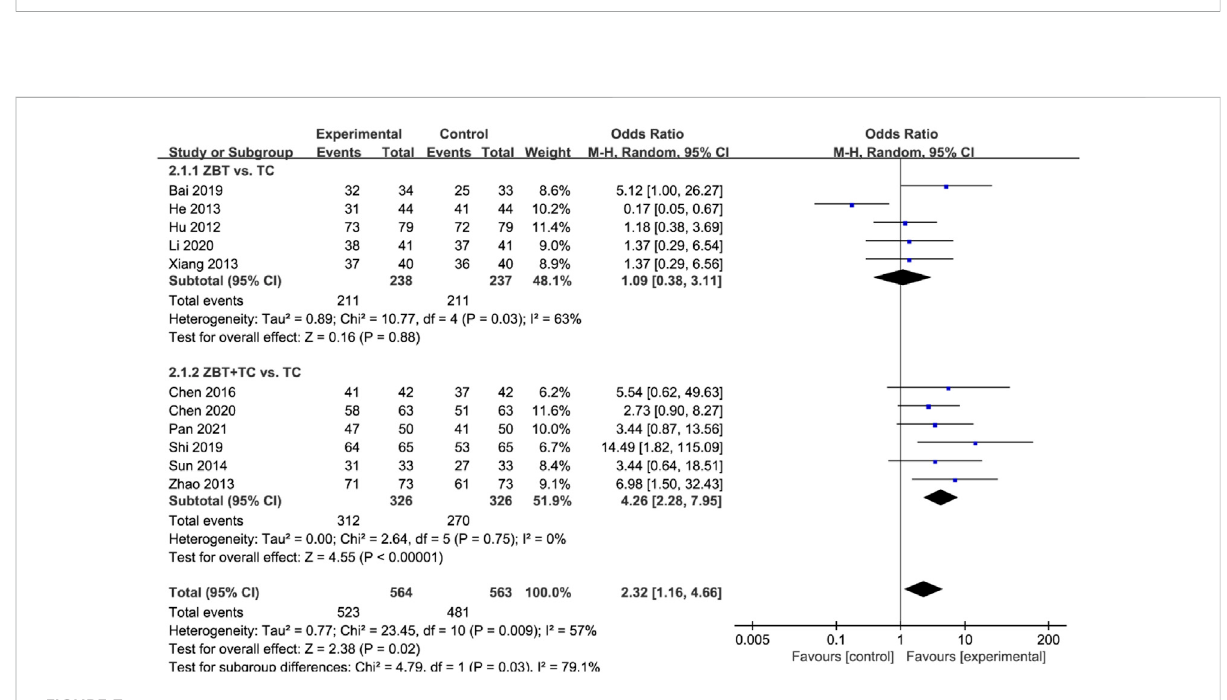
FIGURE 7 Meta-analysis results of the effect of Zhibitai (ZBT) vs. conventional therapy (CT) on total effective